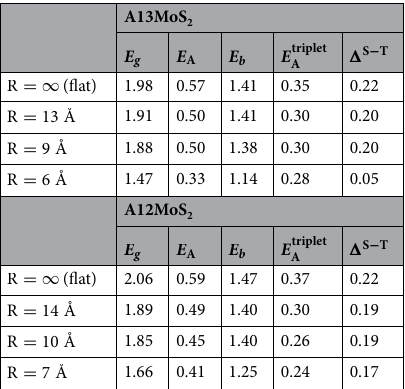
E b (for spin singlet), triplet A . Energy unit in eV.